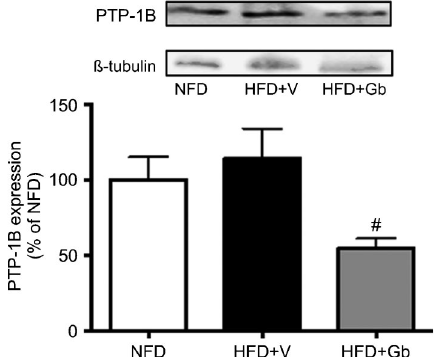
Figure 8. PTP-1B levels in gastrocnemius muscle of NFD (n=10), HFD++V (n=9), and HFD++Gb (n=8) groups after phyttherapy treatment. PTP-1B: protein tyrosine phosphatase 1B; NFD: normal fat diet; HFD: high-fat diet; V: vehicle (saline);